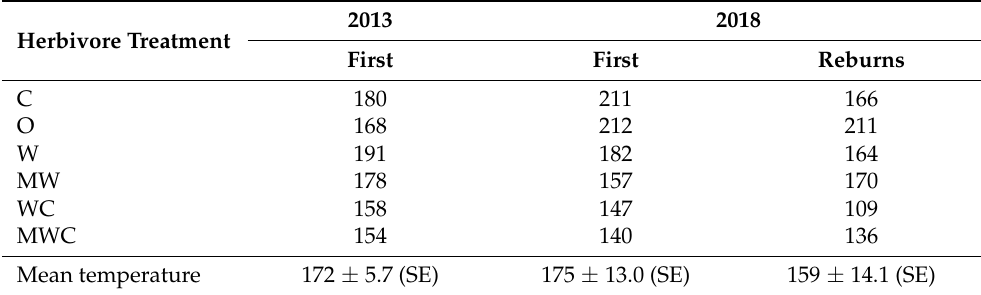
Table 1. Mean fire temperature in each herbivore treatment for the three sets of burns (plots burned for the first time in 2013, plots burned for the first time in 2018, and plots reburned in 2018). Herbivore